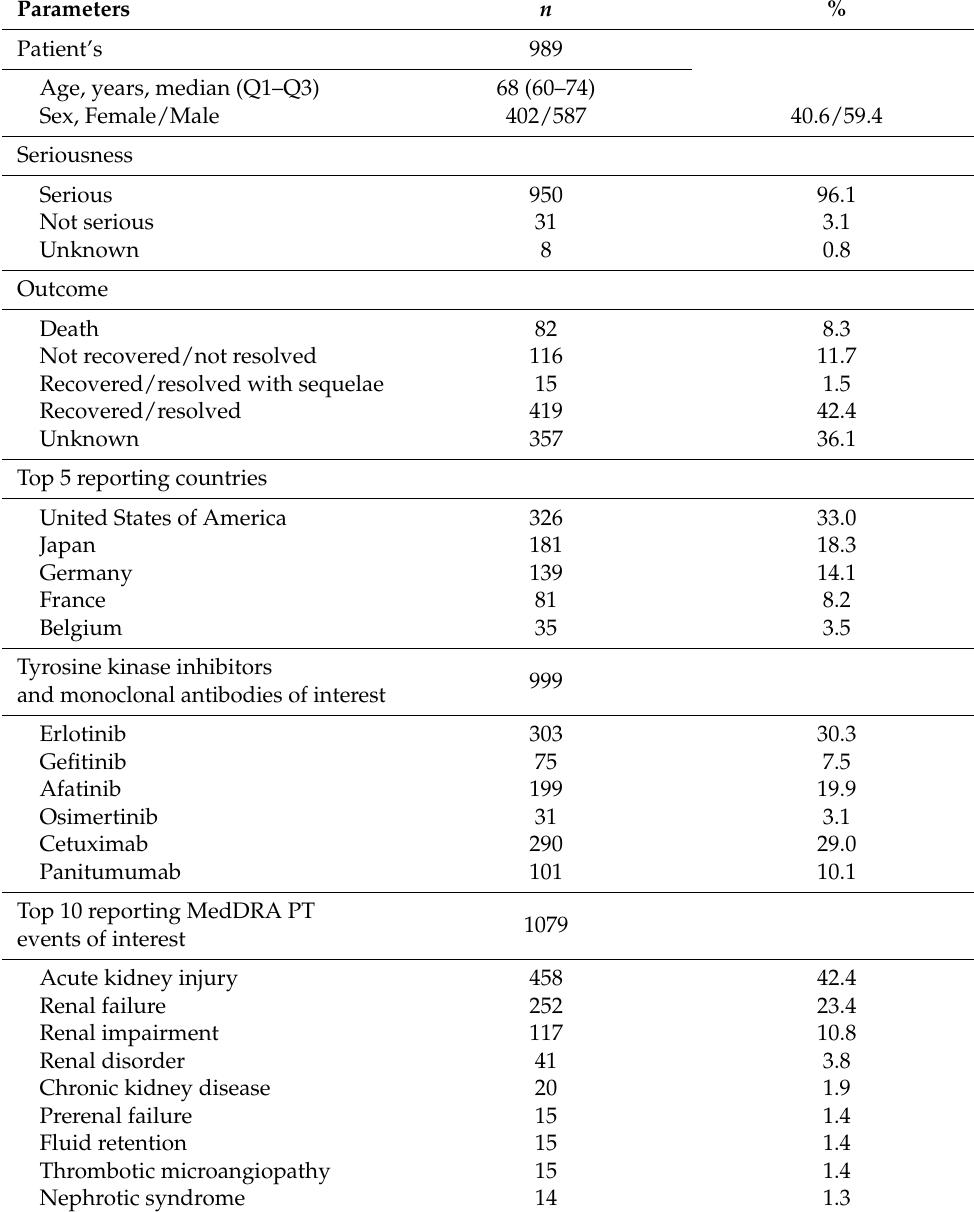
Table 1. Main characteristics of the 989 studied cases. PT: preferred